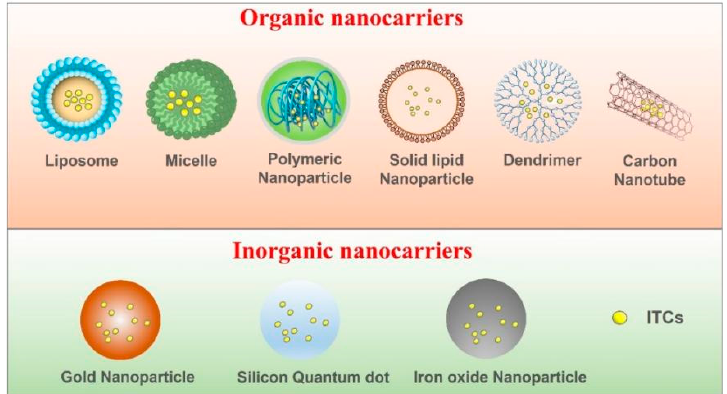
Figure 3. Schematic diagram of major ITCs nano ‐ delivery systems for cancer treatment.